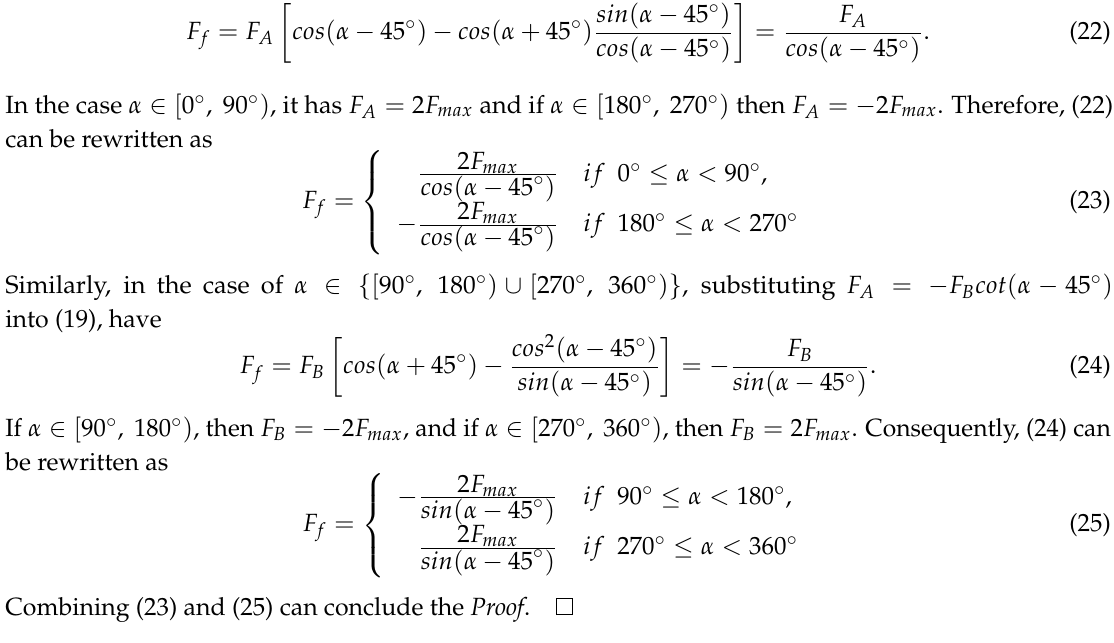
√ Figure 3. The maximum vectored thrust force is 2 2 F max and minimum value is 2 F max . It is easy to see that to align the maximum vectored thrust force with the opposite direction of arbitrarily given sea current, the vehicle’s maximum rotation angle is less than 45 ◦